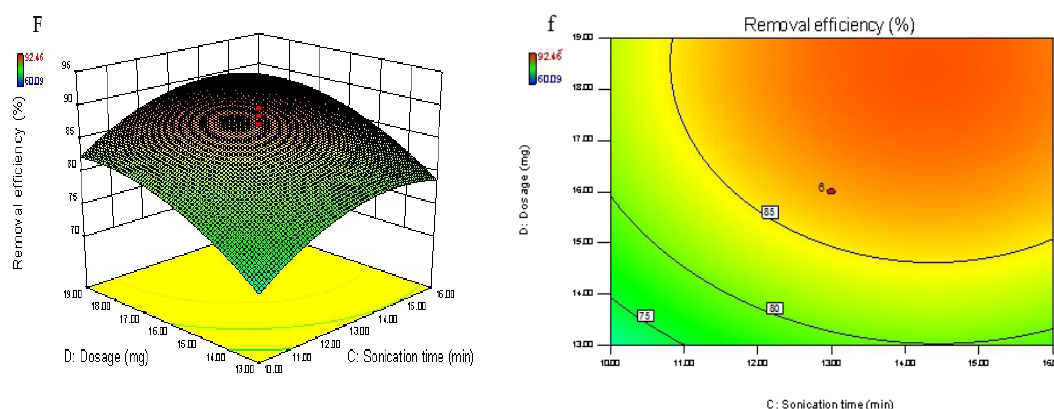
Figure 16. The three-dimensional response surface and contour plots: interactive effects of ( A ) and ( a ) X 1 –X 2 ; ( B ) and ( b ) X 1 –X 3 ; ( C ) and ( c ) X 1 –X 4 ( D ) and ( d ) X 2 –X 3 ; ( E ) and ( e ) X 2 –X 4 ; ( F ) and ( f ) X 3 –X 4 on decolorization efficiency (%) of dye.